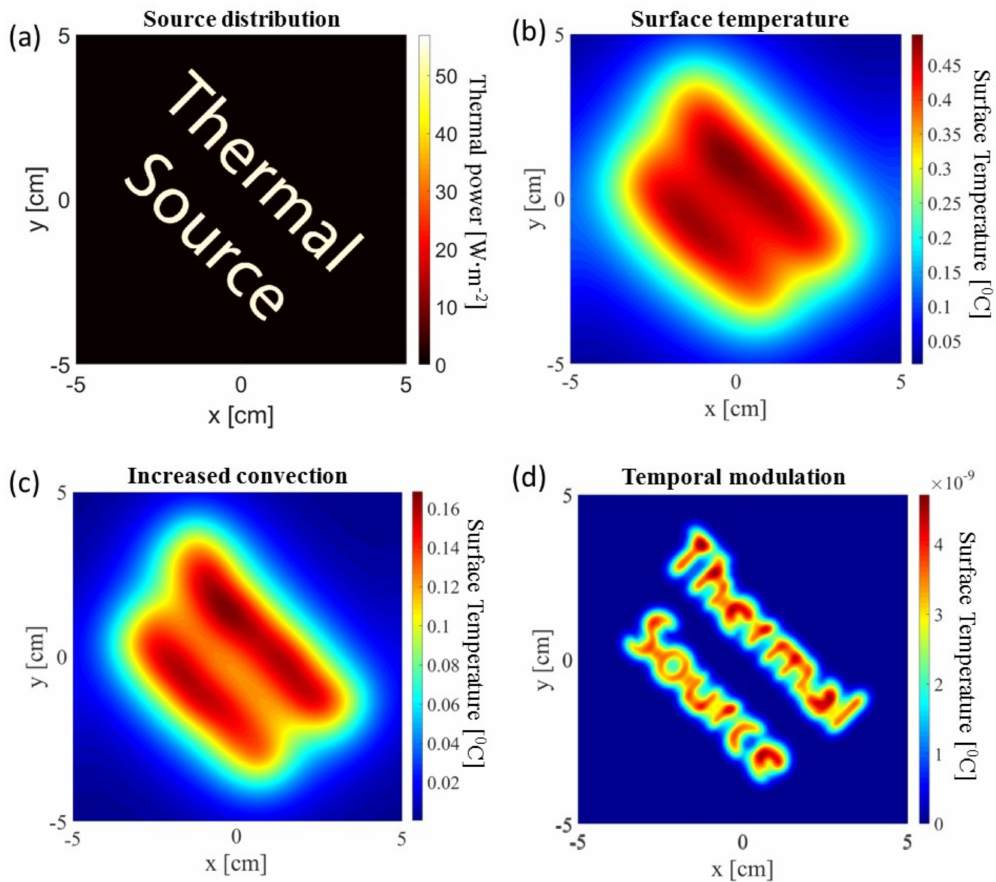
Figure 1. Temperature maps of simulated heat source embedded 8 mm below the surface. ( a ) The thermal source distribution over a 10 × 10 cm area; ( b ) The resulting surface temperature increase; ( c ) The same increase in temperature after a four-fold increase in the heat convention; ( d ) The (temporal) Fourier coefficient of the surface temperature at 1/3 Hz resulting from a source modulation at the same